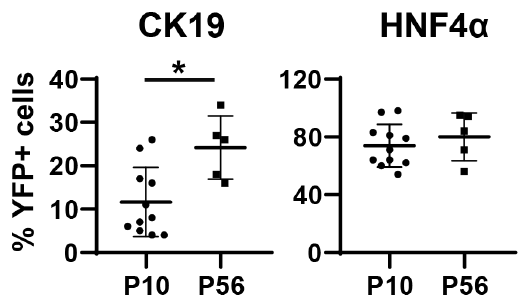
Figure 1. Labeling of cholangiocytes by injection of AAV8-CMV-Cre at P2. ( A ) Schematic representation of the treatment and analysis protocol. Rosa YFP/+ reporter mice were injected with AAV8-CMV-Cre at postnatal day 2 (P2) and tissues were analyzed at P10 and P56, respectively. ( B – D ) Immunostaining analysis. No YFP-labeled cells were detected in the liver of Rosa YFP/+ mice treated with the control vector AAV8-CMV-RFP (B). AAV8-CMV-Cre labeled CK19-expressing cholangiocytes and HNF4 α -expressing hepatocytes (C, D). Yellow arrowheads: YFP+CK19+ cholangiocytes. White arrow: YFP+ cells that do not express CK19 and HNF4 α . 4 ′ ,6-diamidino-2-phenylindole (DAPI) was used for nuclei staining.